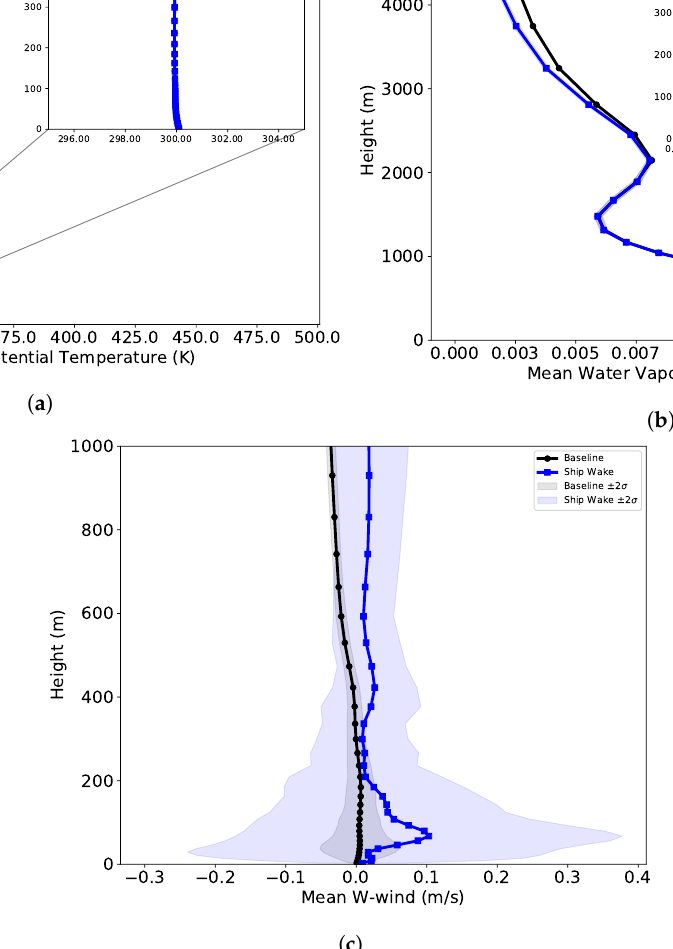
Figure 8. Vertical profiles of ( a ) potential temperature, ( b ) water vapor mixing ratio, and ( c ) vertical wind velocity. Shaded regions represent ± 2 σ from the mean